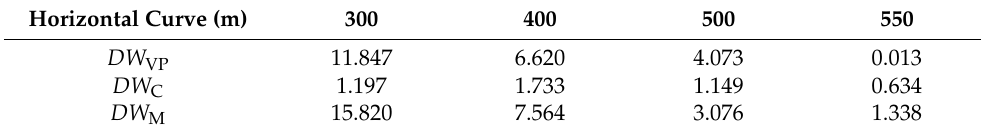
Table 7. SDW over different radii.